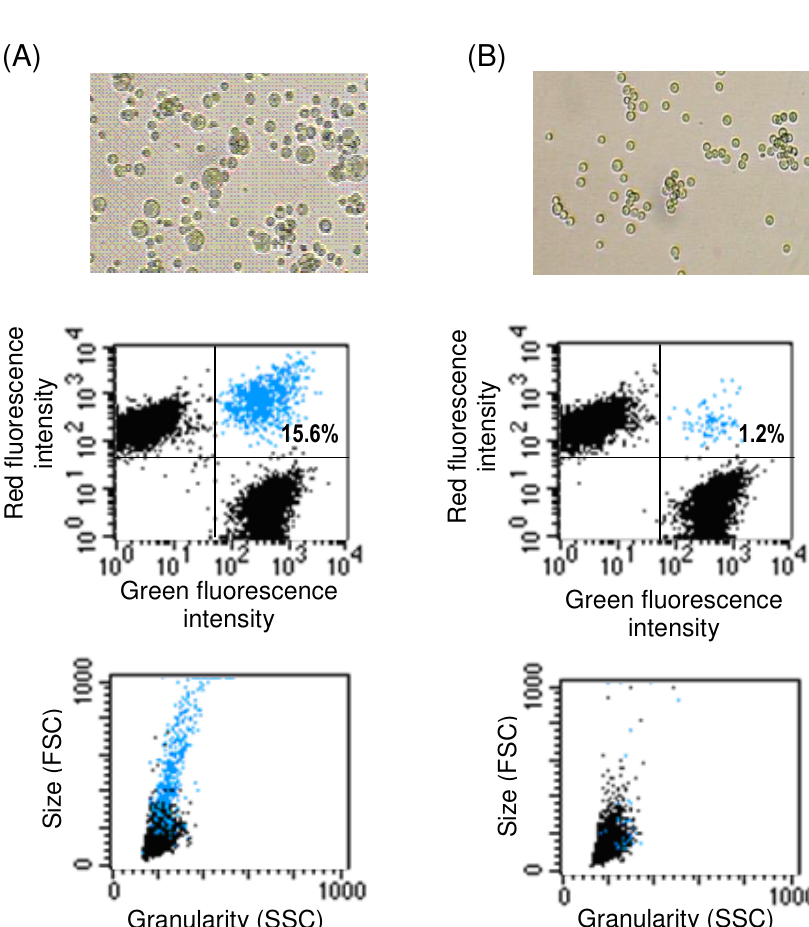
FIGURE 3 . Microscopy view and flow cytometry analysis of syncytia formation in cocultures. Before coculture, Env + and CD4 + cells were labeled with DiO and DiI, respectively. The cocultures of CD4 + Jurkat cells either (A) with Env + fusogenic cells or (B) with Env + nonfusogenic cells (522F/Y) were viewed by light microscopy (10 × ) and analyzed by flow cytometry. The fluorescence and morphological patterns of cells after syncytia formation is shown in dot plots (FL1-H vs. FL2-H and FSC-H vs. SSC-H, respectively). Double-fluorescent particles are shown in blue and their percentage in the coculture is